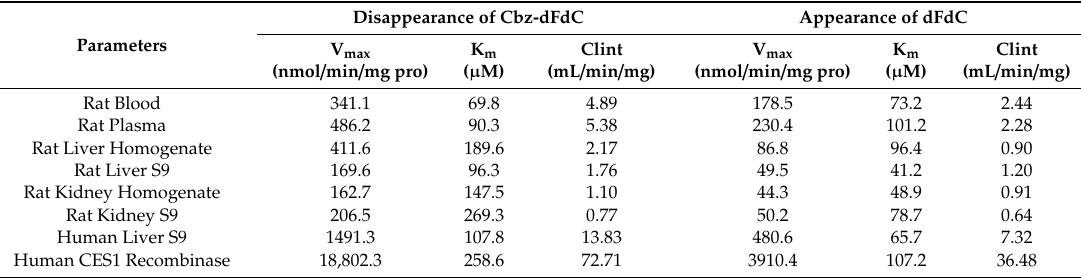
Figure 4. The enzyme kinetics of Cbz-dFdC in rat blood; plasma; tissue homogenate; and S9. Black square and black line represent the observed and simulated values of Cbz-dFdC disappearance in incubation. The blue triangle and blue line represent the observed and simulated values of the dFdC appearance in incubation. Table 2. Enzymatic kinetic